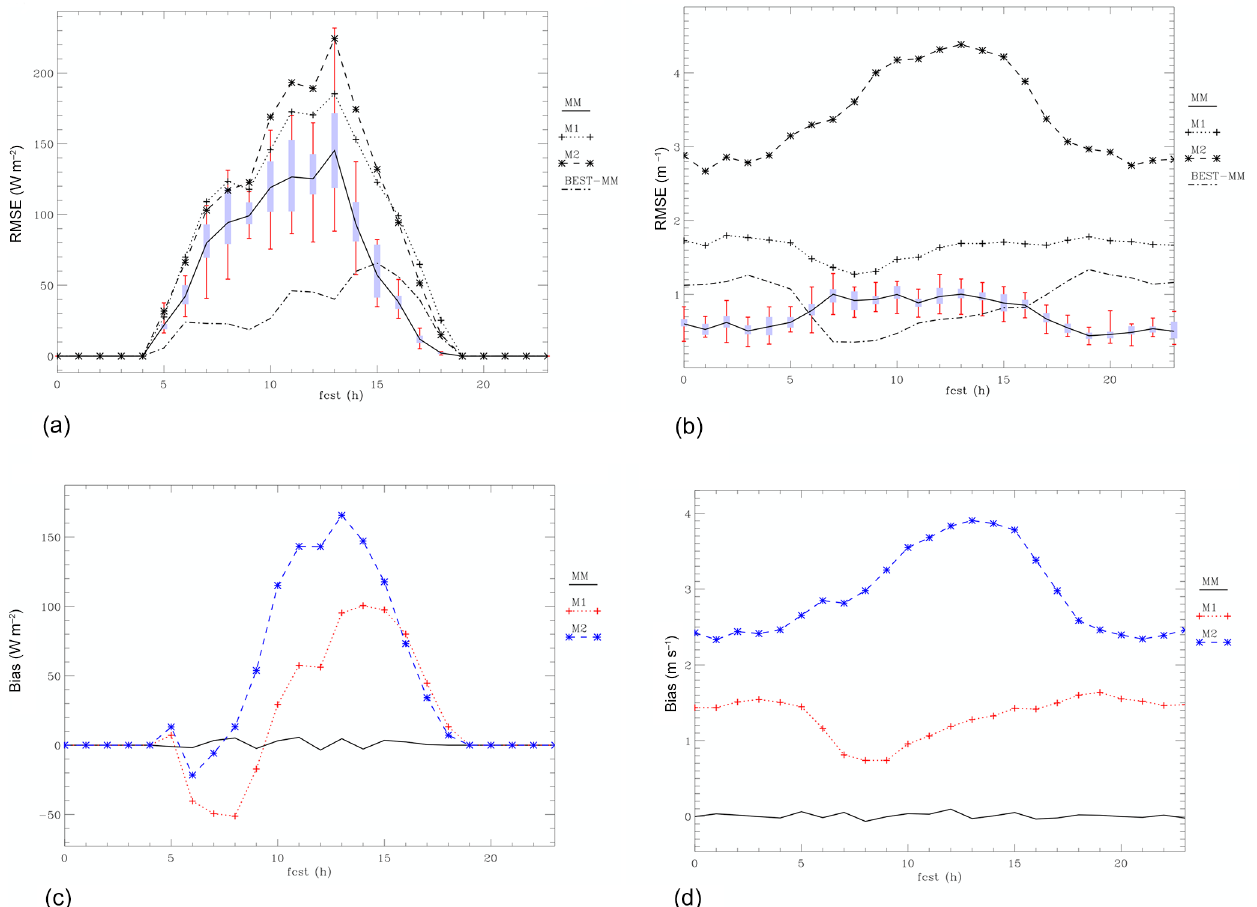
Figure 2. RMSE and BIAS for Lecce site versus forecast time (24h). M1 and M2 are the models forming the multi-model (MM). (a) RMSE for Shortwave Radiation; (b) RMSE for Wind speed; (c) BIA for Shortwave Radiation; (d) BIA for Wind speed. The difference between the RMSE of the best model and that of the MM (BEST-MM) is also shown in (a) and (b) . The RMSE statistic is computed considering the 20 attempts as a whole. The boxes on the MM RMSE curve show the 25th and 75th percentile of the RMSE distribution for the 20 attempts, while the error bars extent between the maximum and minimum value of the RMSE for the 20